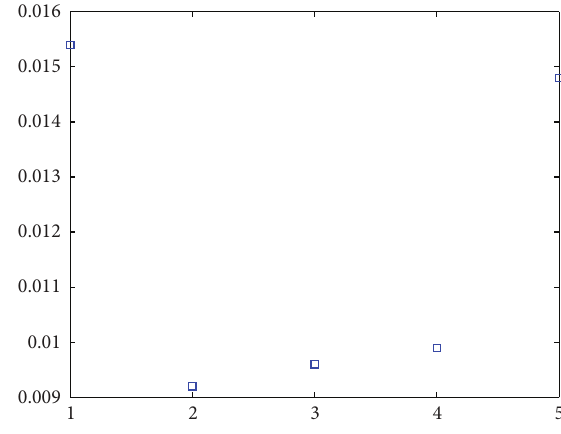
Figure 2: Error of two probabilities with ratio ≥ 1.